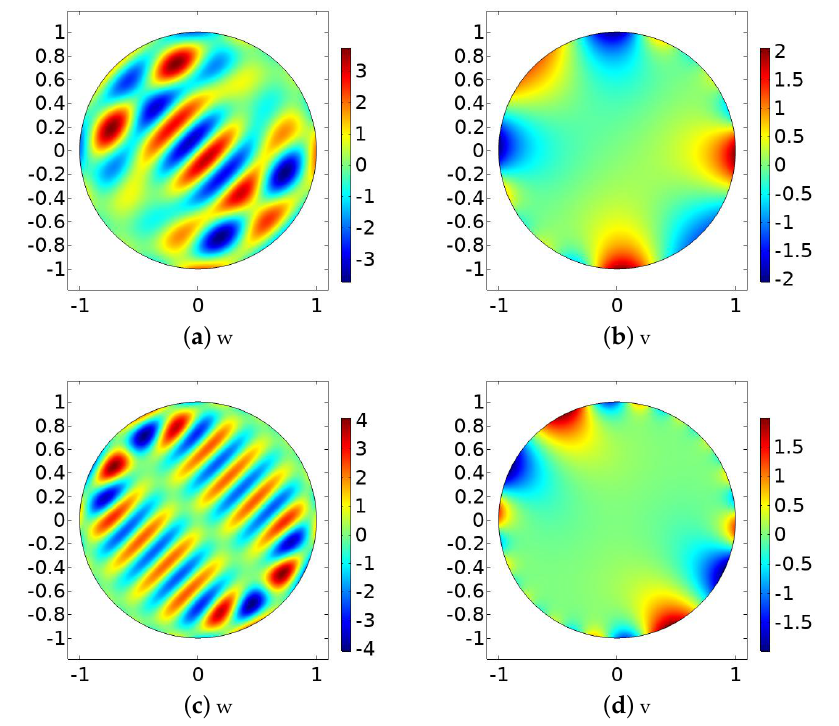
Figure 9. The magnitude of transmission eigenfunctions for a unit disk. ( a , b ): k = 2.576; ( c , d ): k =